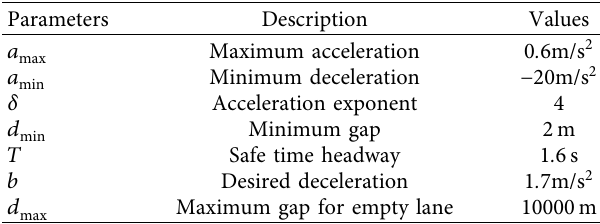
Figure 3: Two-point visual control model. Table 2: Parameters setting of IDM.